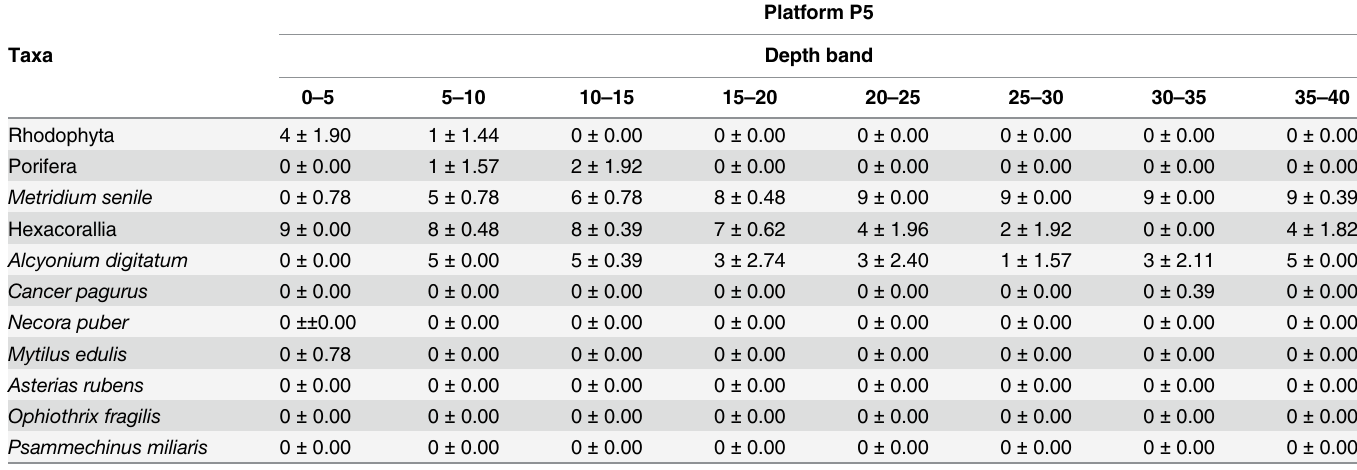
Table 8. Averaged categorised abundance of the 11 high detectable taxa, with 95% confidence interval around the mean, per depth band on plat- form